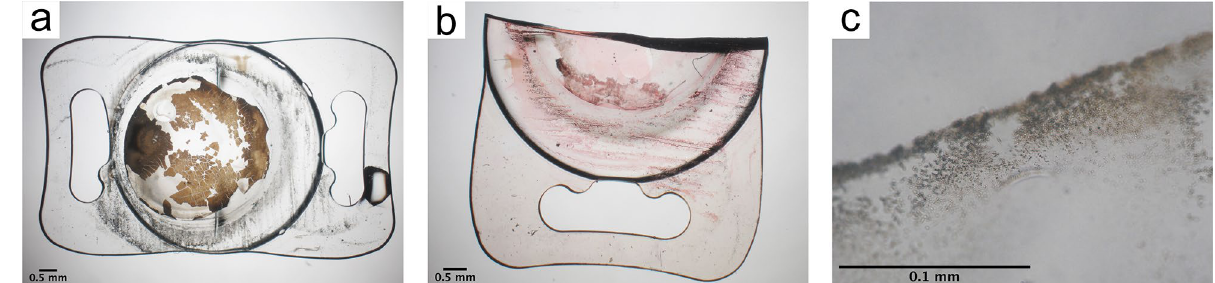
Figure 3. Light microscopy investigation of IOL 3a. Light microscopy ( a ) shows flat and granular deposits on the IOL’s surface. Alizarin Red ( b ) and Von Kossa ( c ) staining reveal the deposits had formed on the surface ( b ) and within the IOL polymer ( c ) and consist of calcium phosphate.